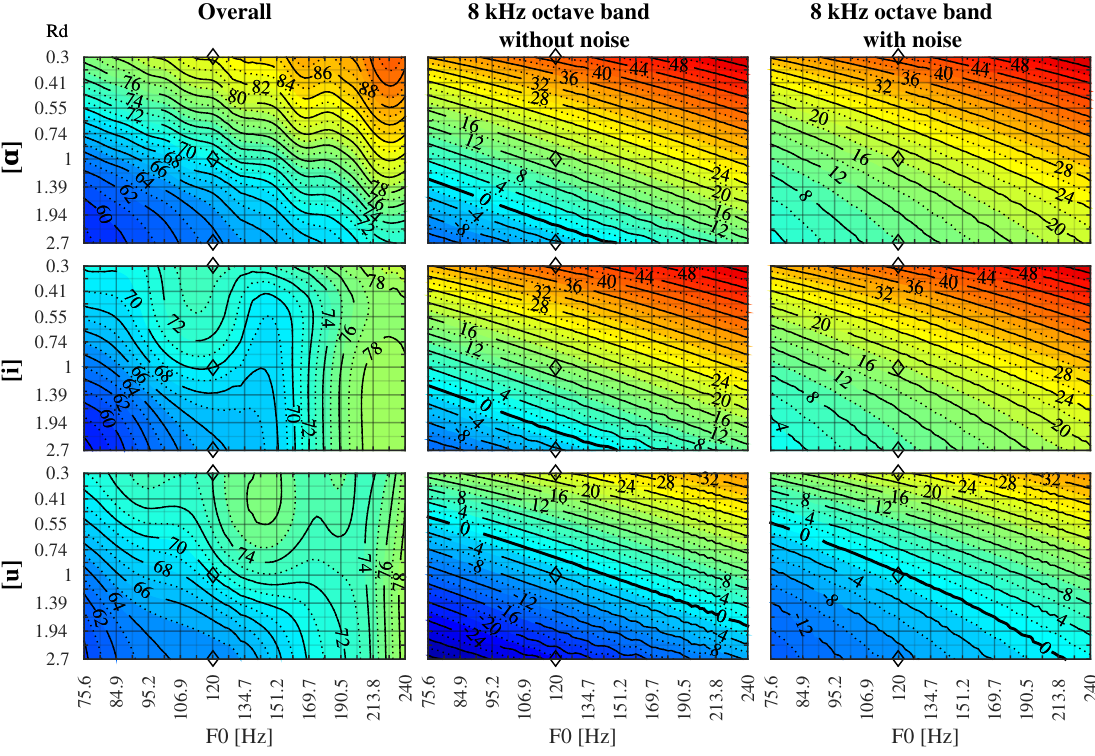
Figure 5. Contour plots showing the overall and HFE levels (dB) in the 8 kHz 1/1 octave band for the realistic vocal tract geometry of vowels [ A ], [i], and [u]. HFE levels are computed with and without introducing aspiration noise in the glottal source model. Each plot depicts the equal level contours for the whole phonation range, representing the F 0 in the abscissas and the R d value in the ordinates. Diamonds represent the points analysed in Section